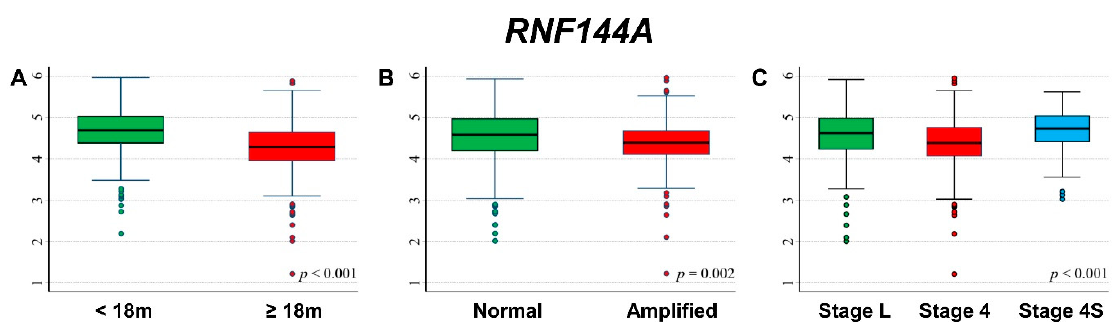
Figure 2. Association between RNF144A gene expression and the main patient characteristics at diagnosis. ( A ) Age (m = months); ( B ) MYCN status; ( C ) Stage (L = localized).